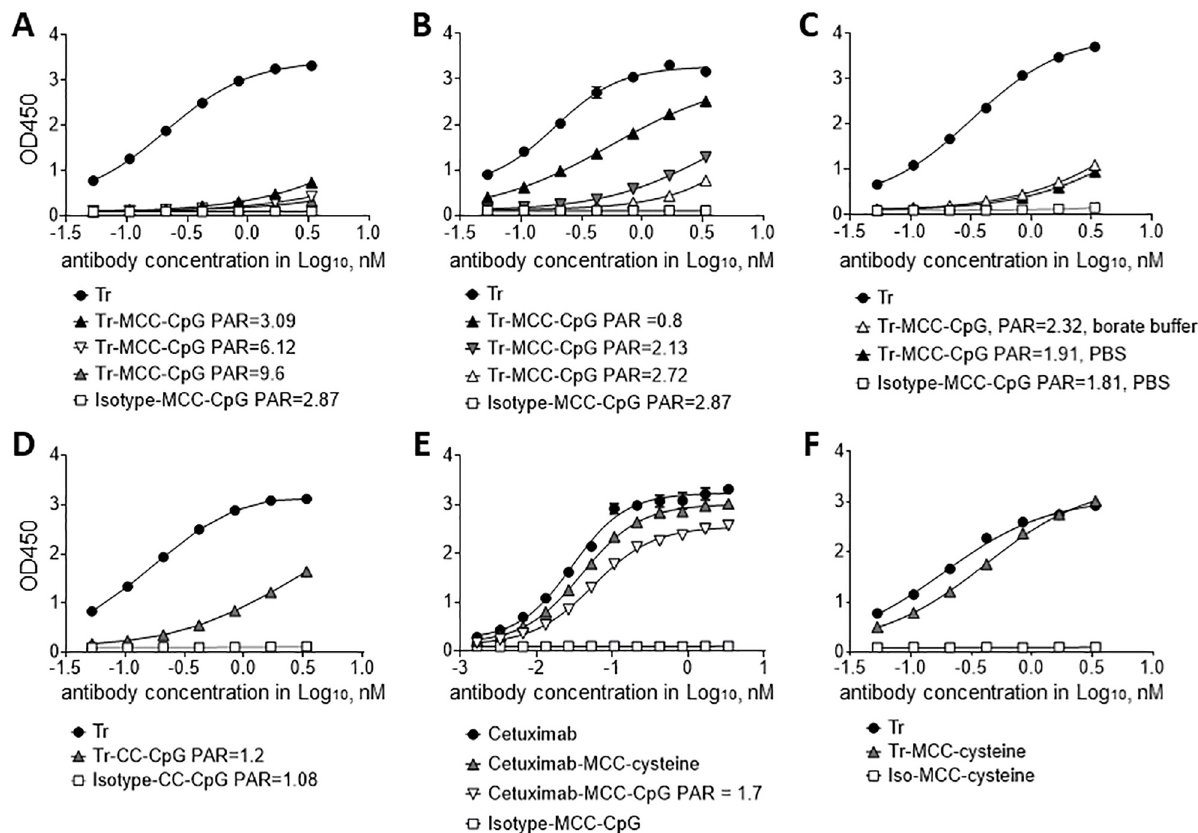
Fig 4. Impact of conjugation conditions on antigen binding properties of conjugates. Trastuzumab (A-C) were conjugated in either PBS (A-C) or borate buffer (C) at various conditions of SMCC and CpG molar excess resulting in conjugates with varying payload to antibody ratios (PAR) as indicated. (D) Trastuzumab was conjugated to CpG using CC. (E) Cetuximab was conjugated to cysteine or CpG using SMCC. (F) Trastuzumab was conjugated to cysteine using SMCC. (A-F) Isotype control antibody conjugated to CpG or cysteine are shown as negative controls. Resulting conjugates were analyzed by ELISA using immobilised human HER2 (A-D, F) or EGFR (E) and anti-human IgG detection antibody. Binding curves were generated using non-linear regression (variable slope) function in GraphPad Prism. Data are representative of at least two independent experiments.